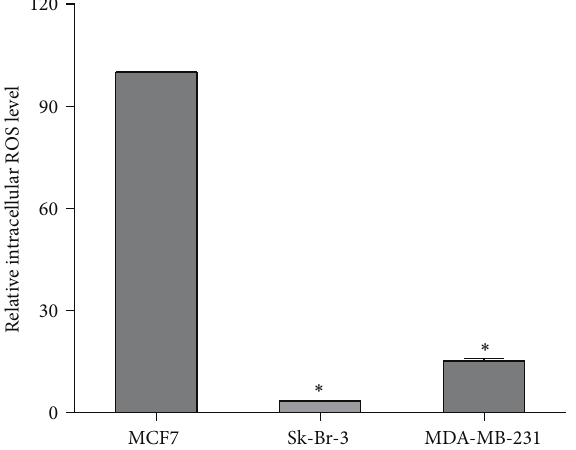
Figure 1: Relative intracellular ROS level in human breast cancer MCF7, Sk-Br-3, and MDA-MB-231 cells under normoxic condition. The highest intracellular ROS level was observed in MCF7 cells and set as